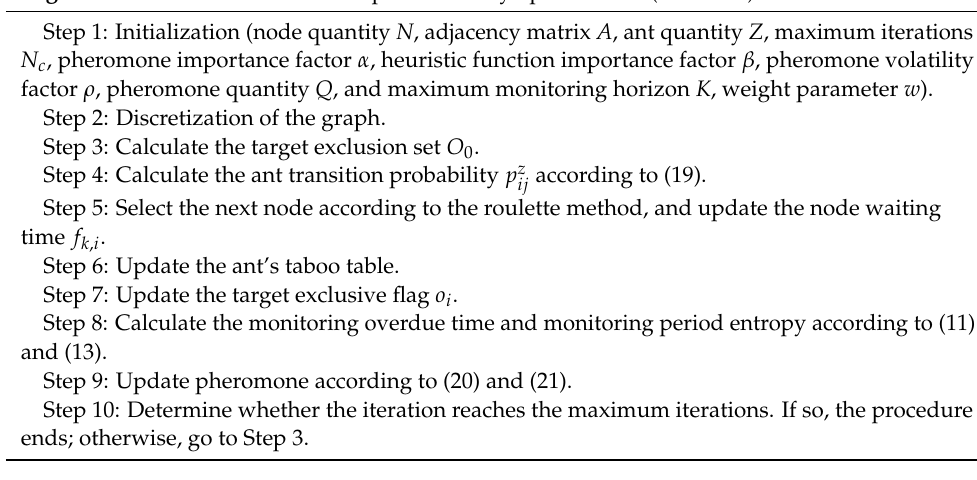
Algorithm 1 : Overdue-aware multiple ant colony optimization (OMACO).